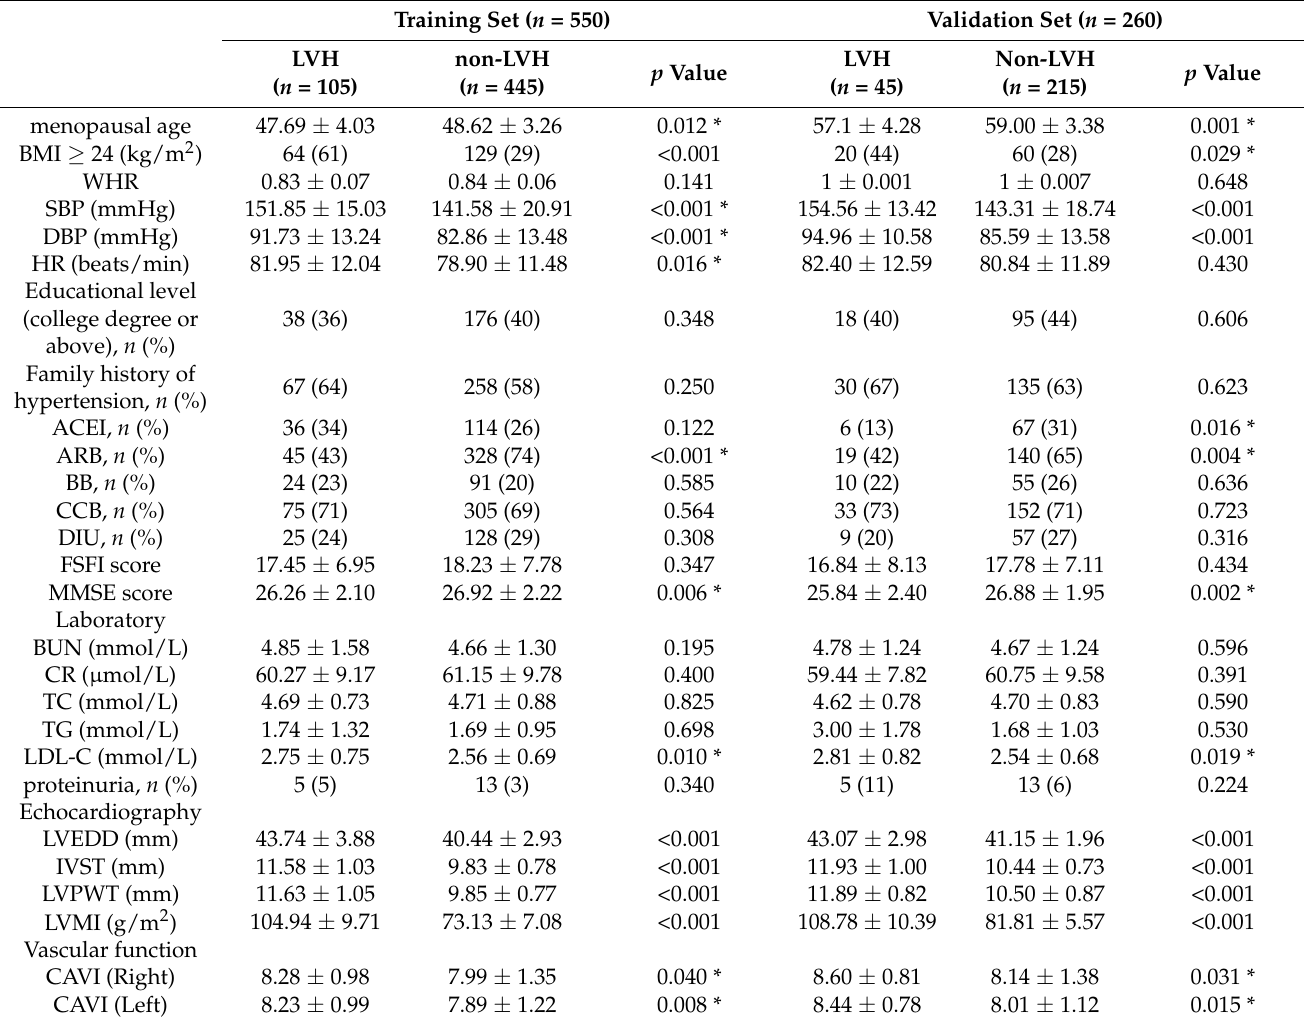
Table 1. Baseline clinical characteristics of postmenopausal women with hypertension in the training and validation